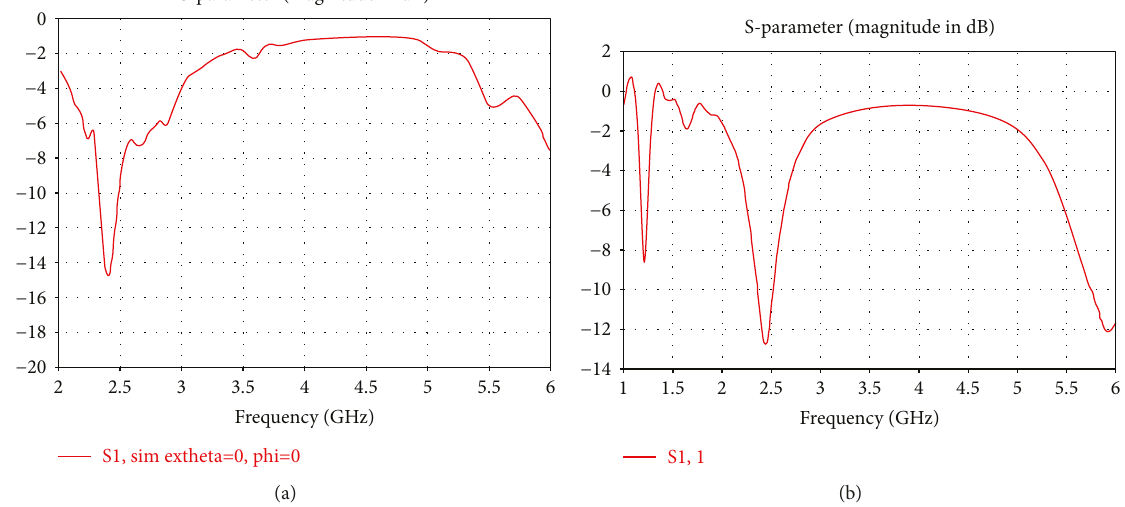
Figure 6: (a) S-parameter graph of 128-element array. (b) S-parameter graph of single Z-shaped